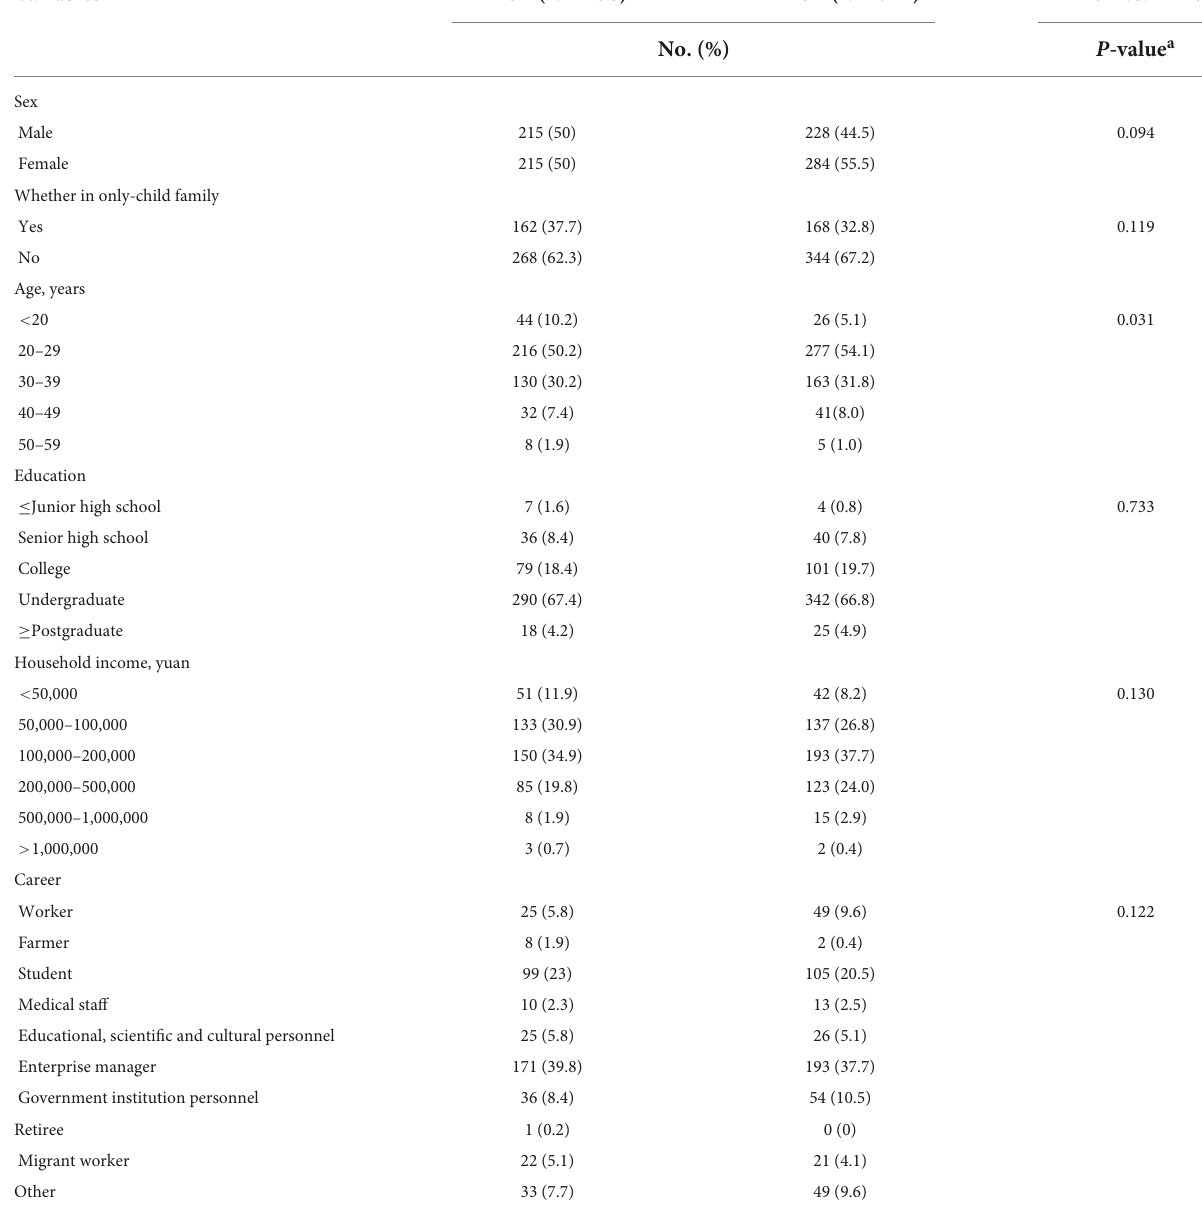
TABLE 1 Demographic characteristics of participants of two